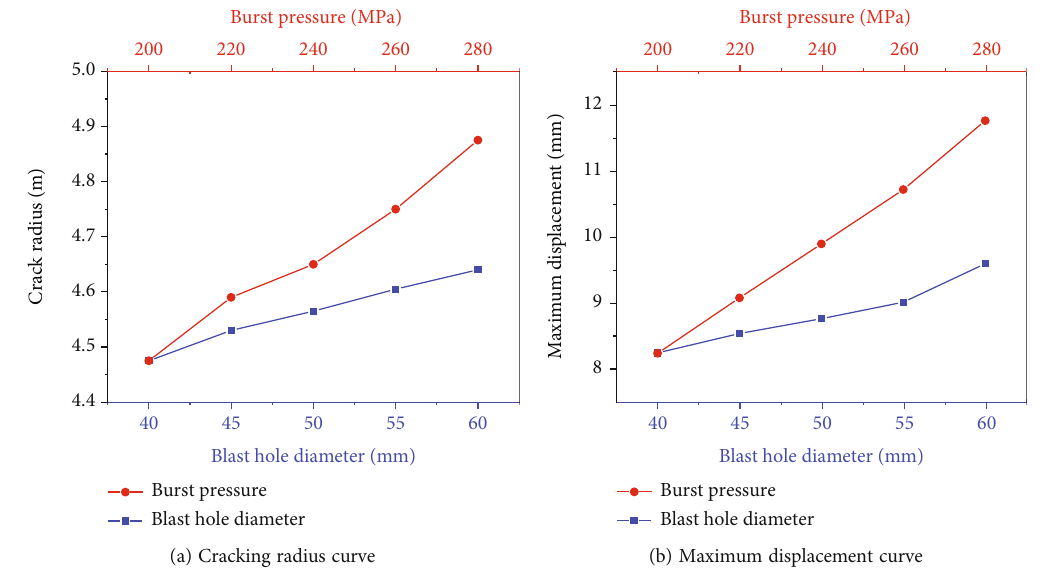
Figure 10: Fracturing radius and maximum displacement under di ff erent vent diameters.